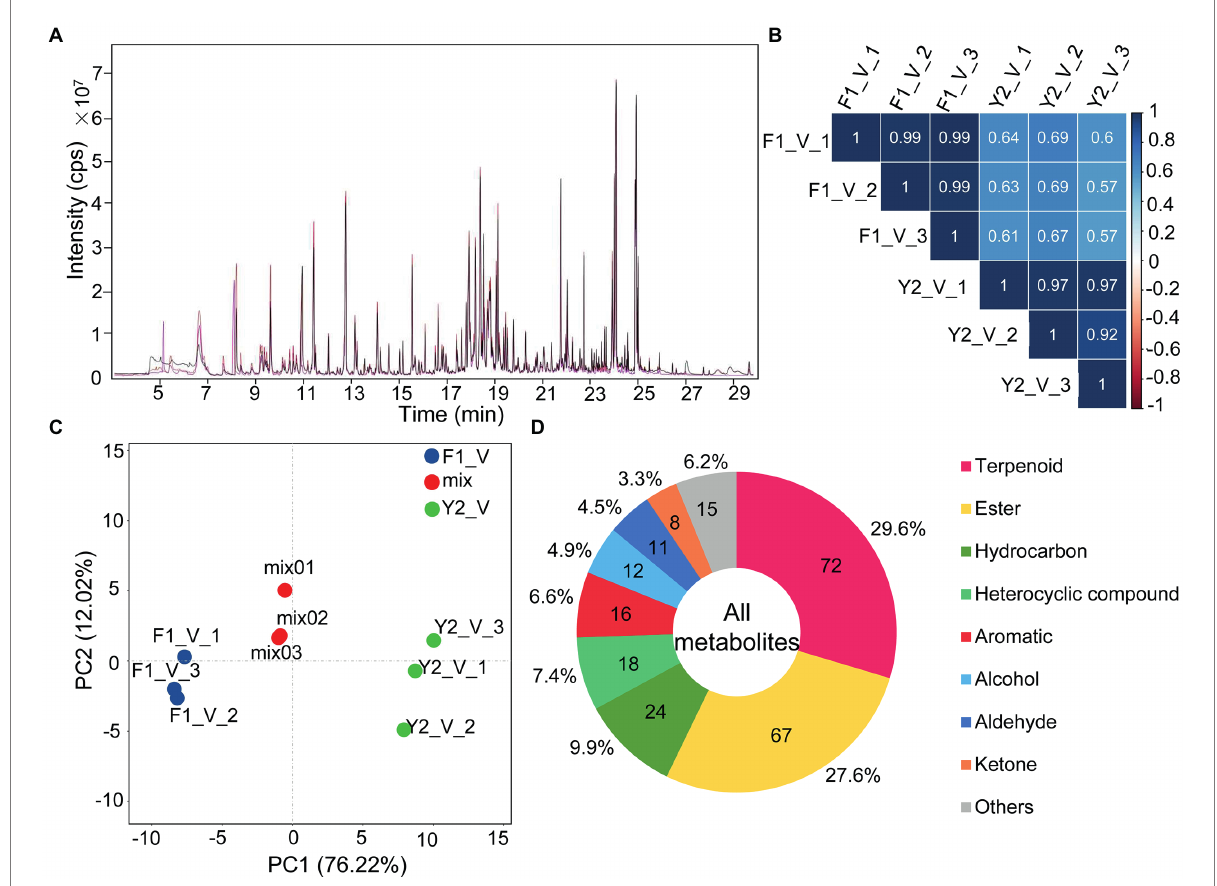
FIGURE 2 Overview of the metabolomics analysis. (A) Overlapping analysis of the total ion current in different quality control samples. The abscissa and the ordinate represent the retention time (min) and the intensity of the ion current (cps: count per second), respectively. (B) Pearson’s correlation analysis of LJF VOC profiles. (C) Principal component analysis (PCA) of LJF VOC profiles. (D) Component analysis of the identified VOCs of